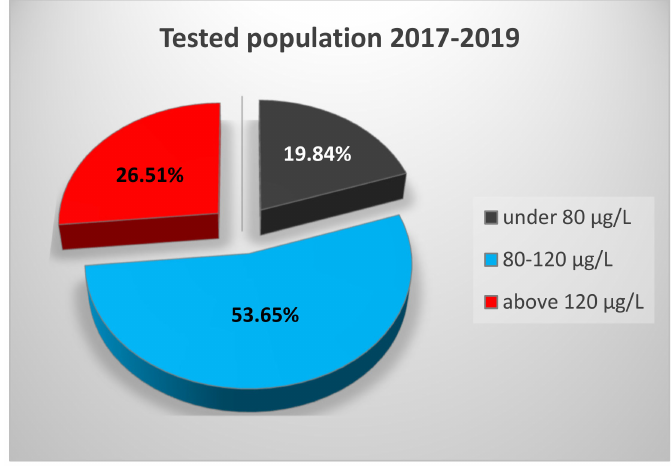
Figure 4. Distribution of tested population compared to the SeS reference interval of 80–120 µ